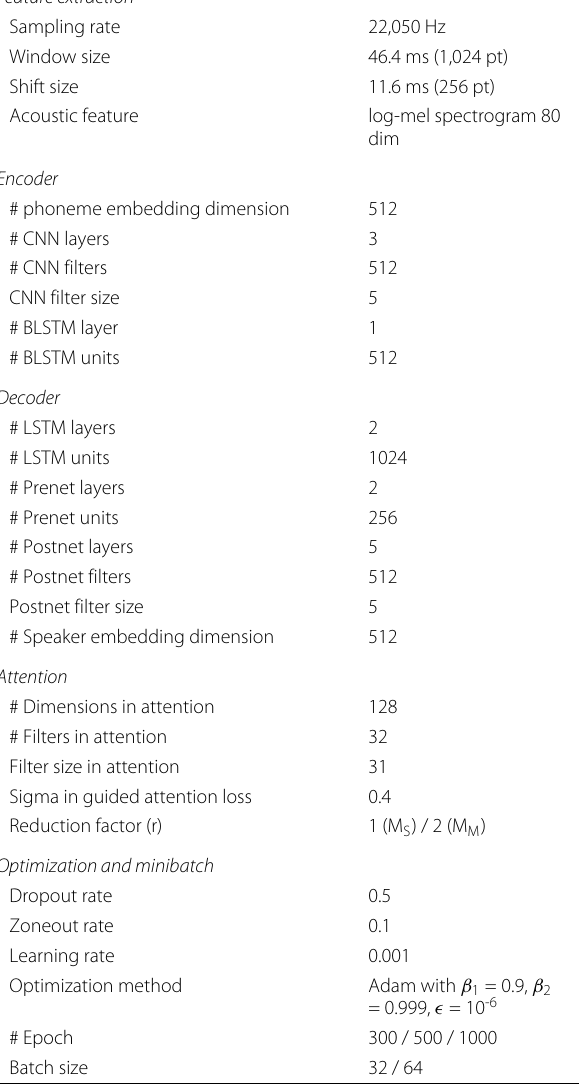
Table 1 Hyper-parameters and network